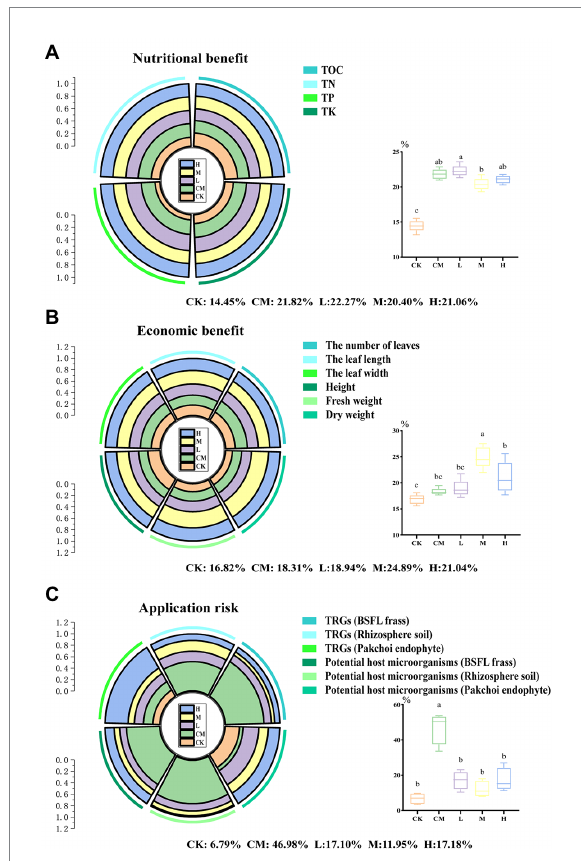
FIGURE 7 The best larval density group analysis. Nutritional benefits (A) , economic benefits (B) , and application risks (C) were considered. Each part of the pie represents one influencing factor, the different color blocks in each influencing factor indicate each larval density, and the proportion of each block indicates the ratio of each larval density to the influencing factor. Significant difference analysis is depicted to the right of each consideration, and different letters indicate significant differences. Significant differences between the means were determined by Tukey’s test. Differences were considered significant when p < 0.05, and different lowercase letters indicate significant differences. “RS” means initial pure soil, “CK” means untreated soil, “CM” means untreated manure without BSFL, “L” means 50 BSFL cultured in 100 g of fresh manure, “M” means 100 BSFL cultured in 100 g of fresh manure, “H” means 1,000 BSFL cultured in 100 g of fresh